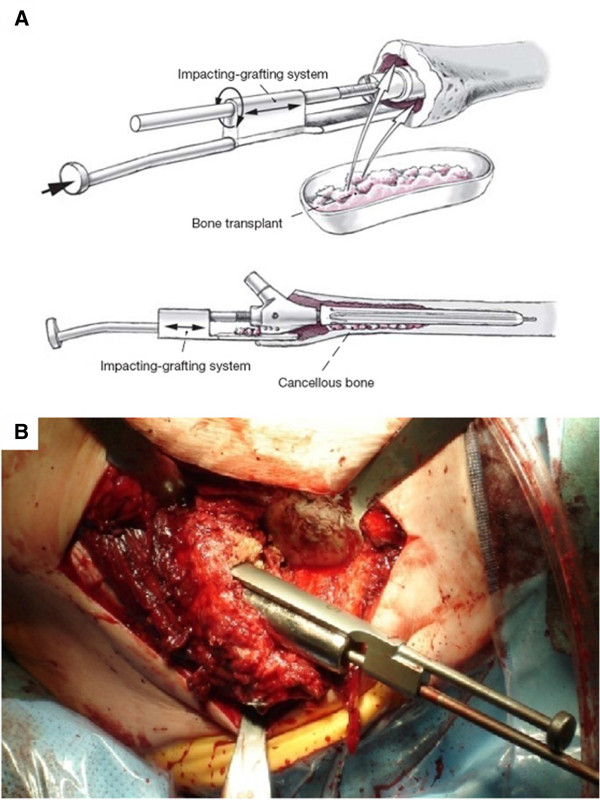
Surgical technique. Filling metaphyseal bone defects by impaction bone grafting, using the press fit impaction technique. Special impactors fit over the central guide rod and laterally “bypass” the trial implant, permitting meticulous compression of the allograft chips introduced into the metaphysis. (A.) Illustration from
[25]; (B) intraoperative photograph.